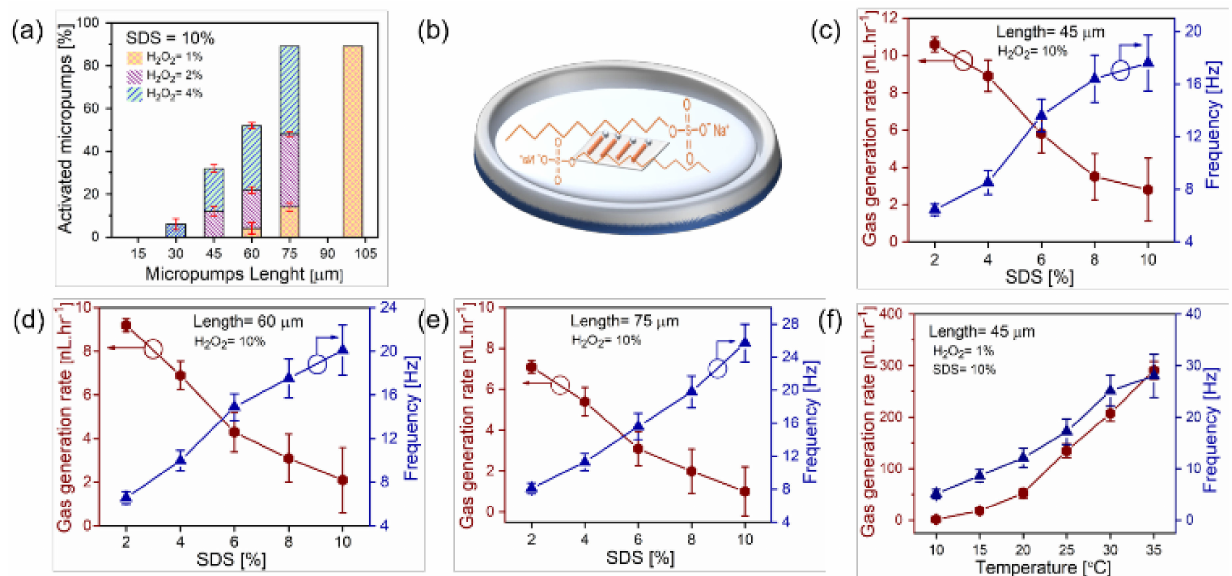
Figure 5. Activation of microtubes at a constant SDS (10% v / v ) and different concentrations of H 2 O 2 , which are represented by the cross right-tilted and left-tilted regions. ( a ) Dependence of micropumps’ lengths on activity, i.e., generation of oxygen microbubbles. ( b ) A schematic image of the SDS molecule and catalytic microtubes in the H 2 O 2 solution. ( c – e ) Analysis of oxygen gas generation rate and bubble frequency from the different microtube lengths at constant H 2 O 2 concentration. ( f ) Oxygen generation from a 45 µ m catalytic microtube at various temperatures. Reproduced with permission from Ref. [102], Copyright 2020,